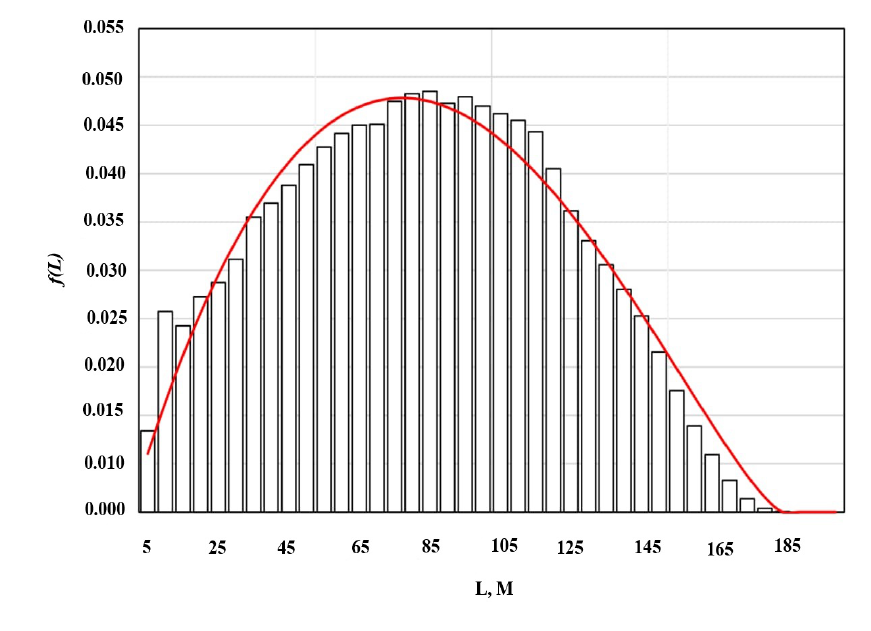
Figure 10. Distribution of the average length of routes (red curve given by Equation